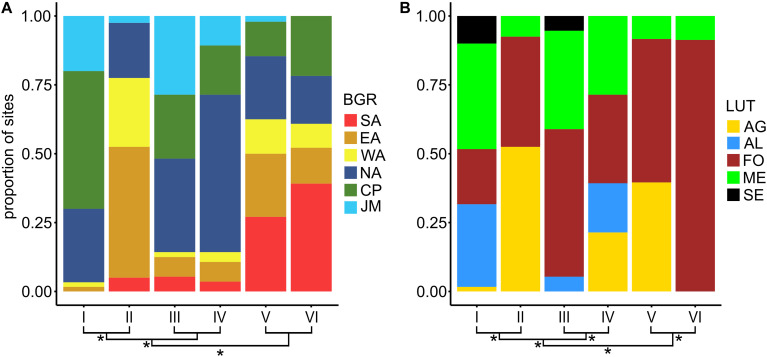
Proportion of sites from the six biogeographic regions (BGR; A) and the five land-use types (LUT; B) among the six bacterial community types (BCTs). BCT I to VI correspond to clusters based on Bray Curtis dissimilarities based on mean OTU abundances for each site and the Ward’s minimum variance method (Ward D2) mean OTU abundances per site. Clustering of BCT I to VI is shown at the bottom of the barplots. Asteriks at branchings denote significantly (Fisher exact test, adjusted p-value < 0.05) different composition of the BGRs, i.e., Jura Mountains (JM), Central Plateau (CP), Northern Alps (NA), Eastern Central Alps (EA), Western Central Alps (WA), and Southern Alps (SA), or of the LUTs, i.e., alpine grassland (AG), arable land (AL), forest (FO), meadow (ME), and settlement (SE).